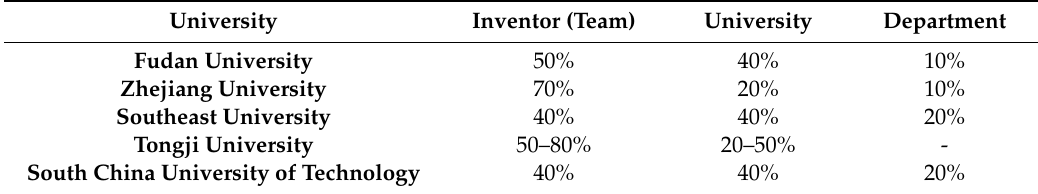
Table 6. The income distribution coe ffi cient of several typical